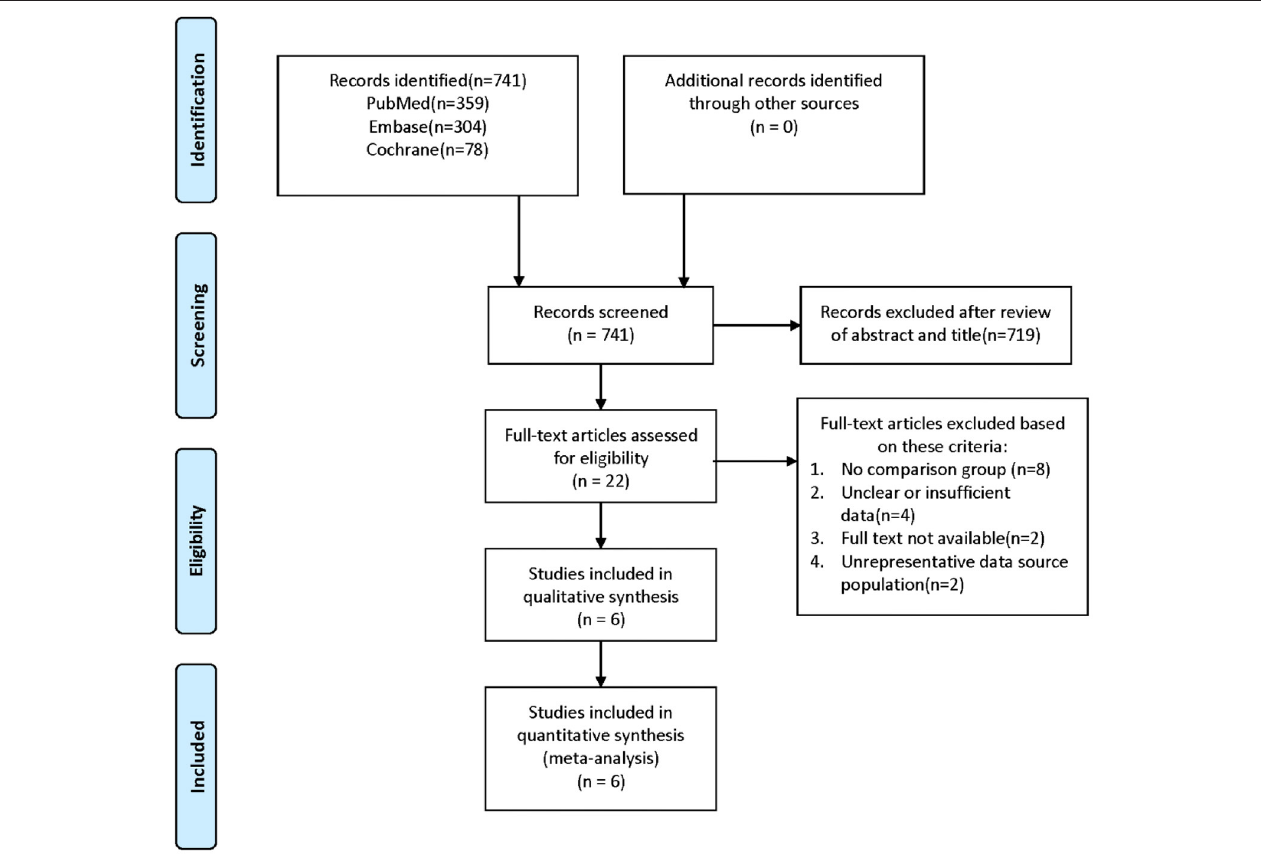
FIGURE 1 | Flow chart of the literature